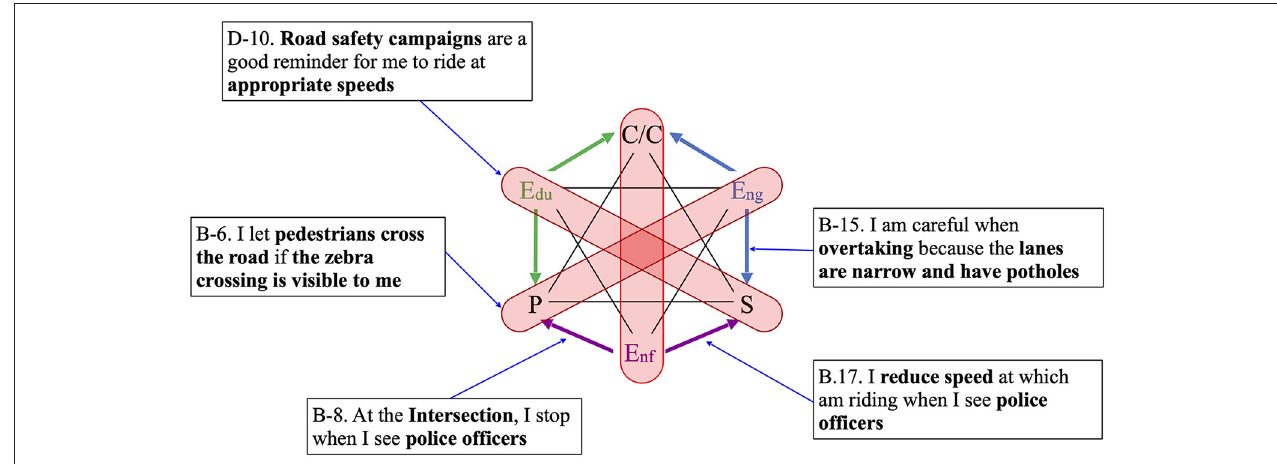
FIGURE 1 | Relationship between safety hexagon and questionnaire